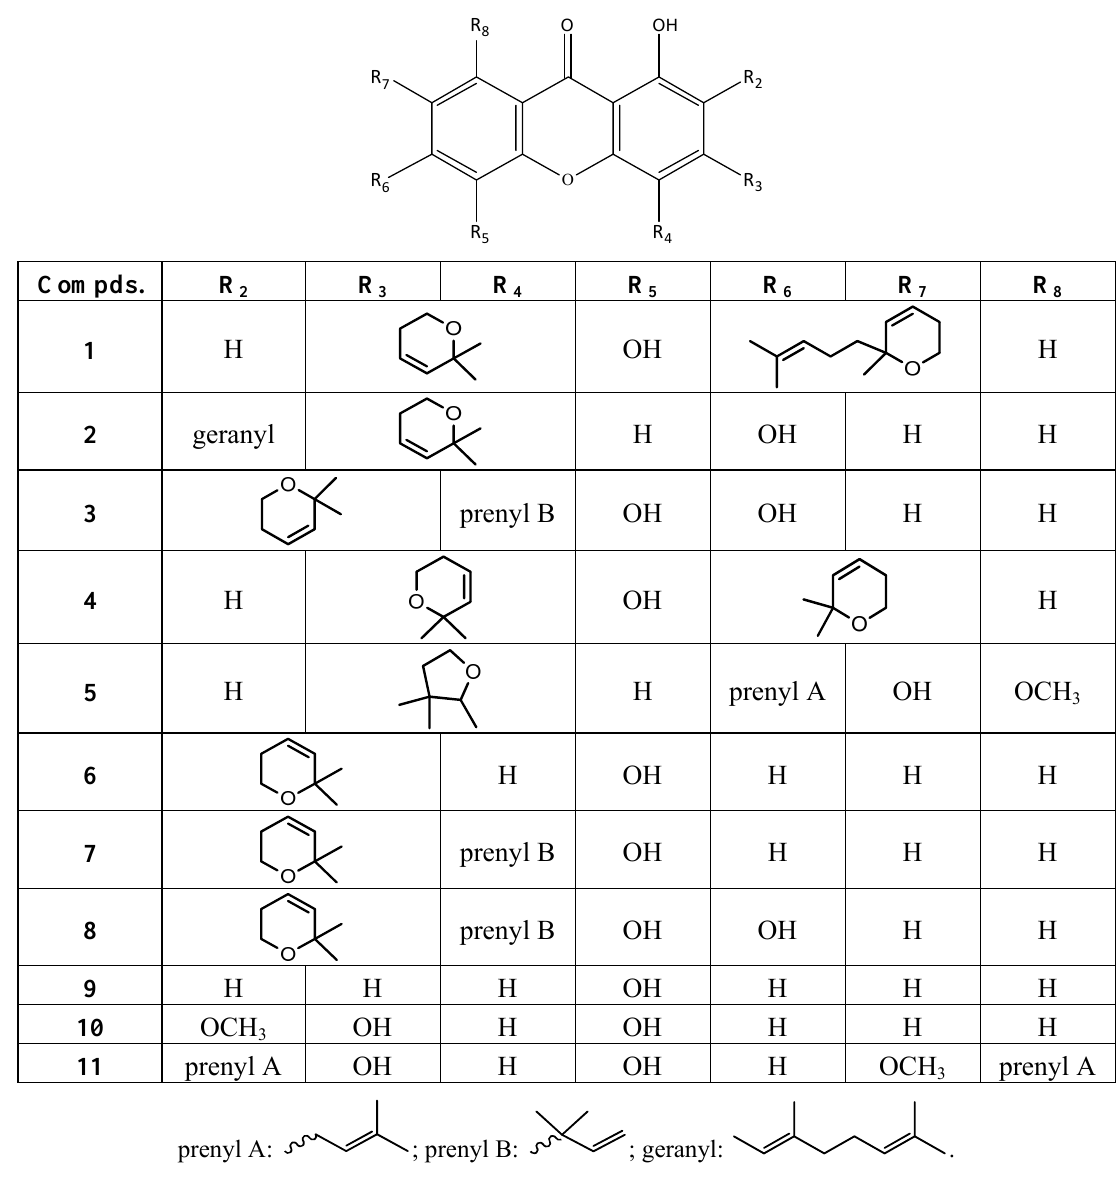
Table 1. Xanthone derivatives from M. beccariana , M. ferrea and M. congestiflora .